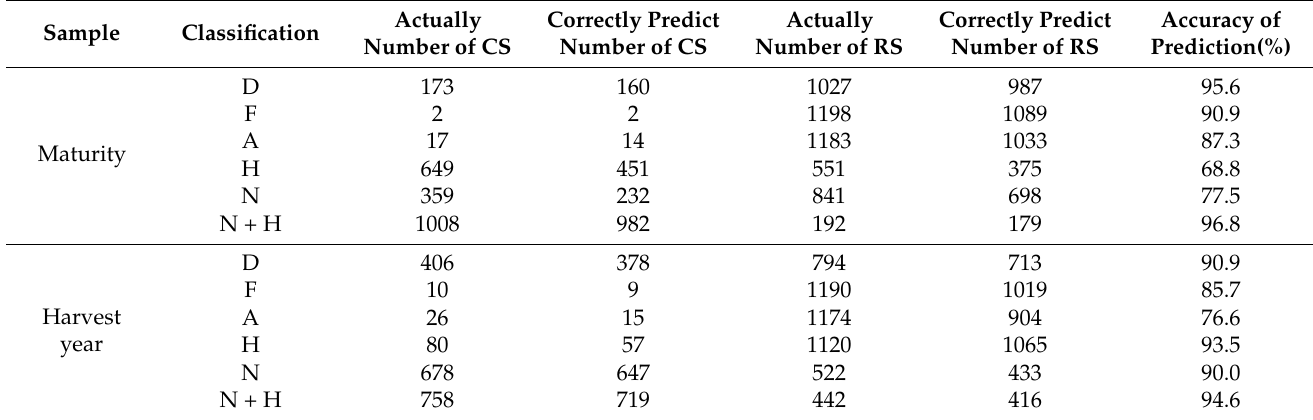
Table 5. Seed germination prediction of different maturity and harvest years based on nCDA .